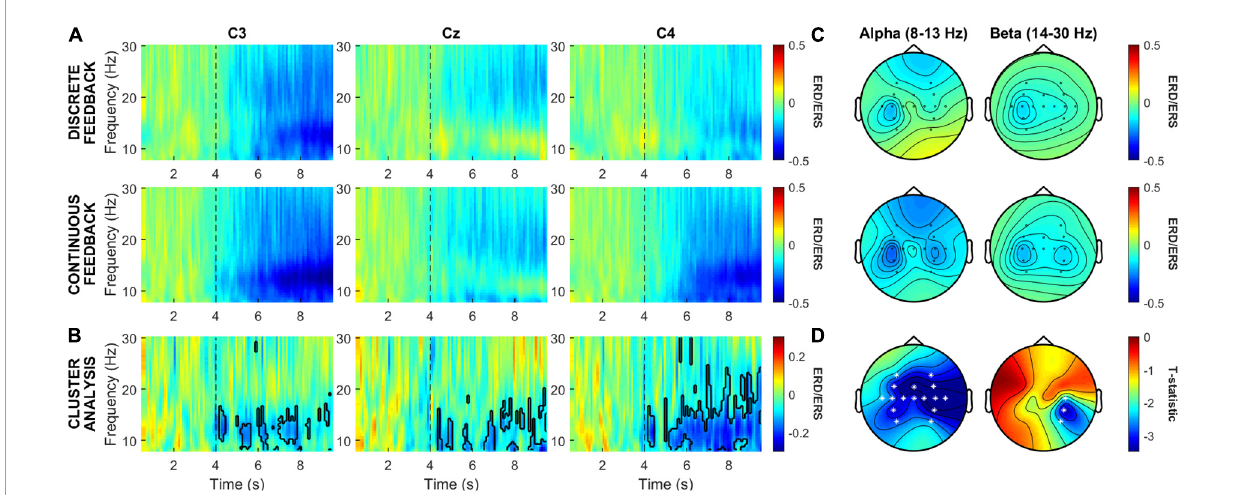
FIGURE4 ERD/ERS analysis for the continuous and discrete feedback in the alpha and beta frequency bands. (A) Grand average ERD/ERS time-frequency maps of central channels C3, Cz, and C4. (B) Effect between the averaged ERD/ERS of the continuous and the discrete feedback in electrodes C3, Cz, and C4. (C) Topographic maps of the averaged ERD/ERS during the MI task in the alpha and beta frequency bands for both feedback types. (D) Topographical distribution of the statistically different clusters ( p < 0.05) between the continuous and the discrete